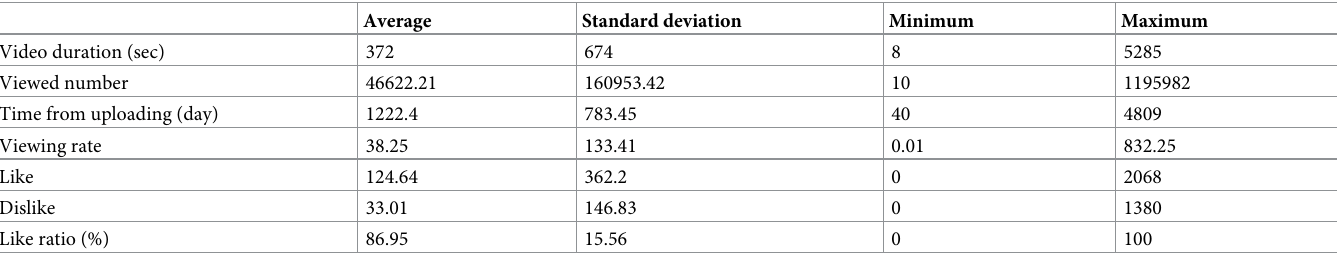
Table 3. Properties of the examined YouTube videos (n =